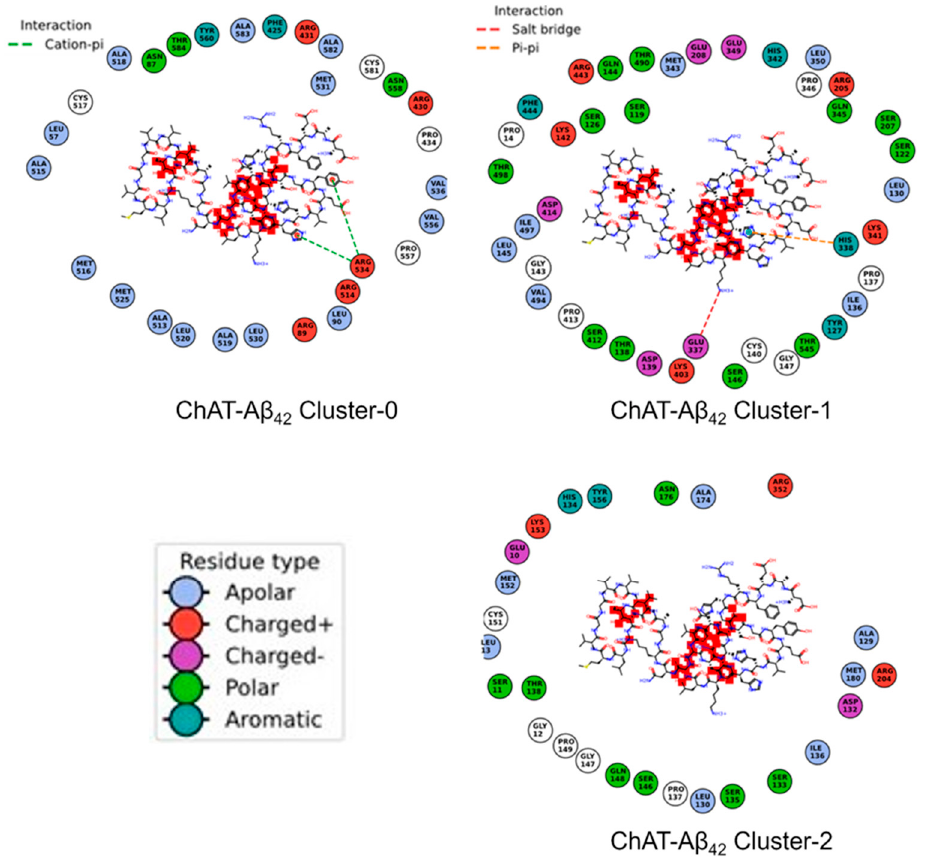
Figure 11. Contact maps between the ChAT protein and A β 42 peptides in the complexes. The amino acid residue types are given with the color codes as blue (Apolar), red (‘+’ charged), purple (‘-’ charged), light green (Polar), dark green (Aromatic).